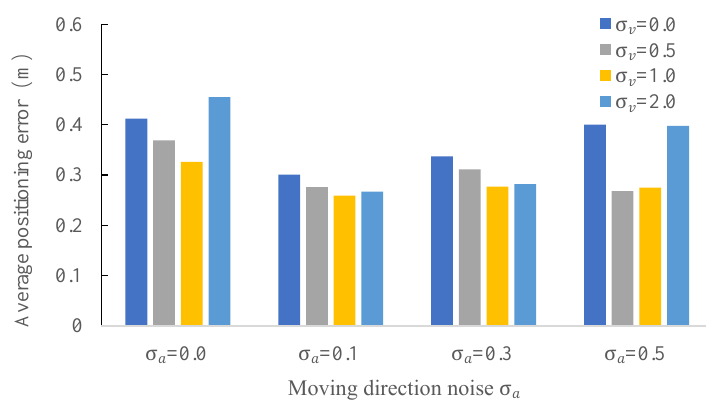
Figure 10. Positioning accuracy under the impact of different velocity noise σ v and moving direction noise σ a .